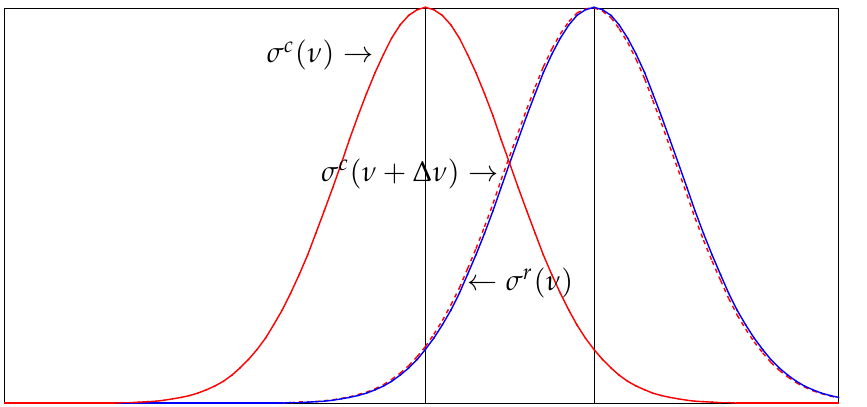
Figure 1. Stretching of function σ ( ν ) for ν defined in some specific range in order to fit with σ r ( ν ) , ∆ ν is the maximizer of correlation coefficient C s given in Equation (1).